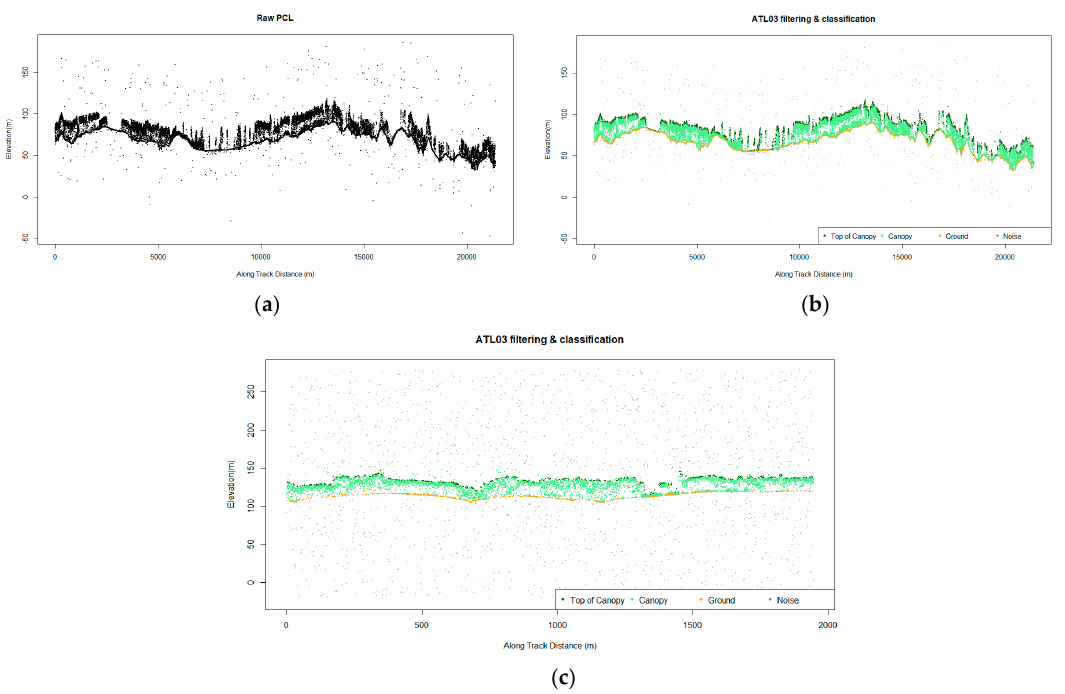
Figure 2. ( a ) Actual ICESat-2 data over pine forests in Texas; ( b ) Filtered and classified ICESat-2 data over pine forests in Texas; ( c ) Filtered and classified simulated ICESat-2 data in